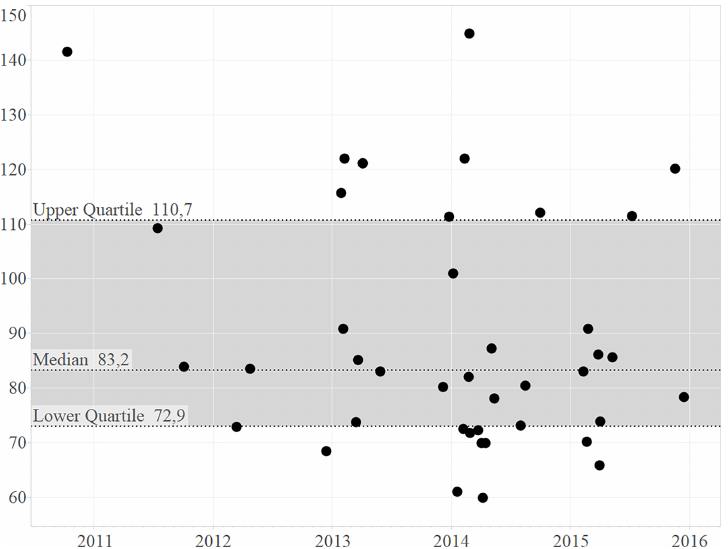
Fig 2. Age at first calving by calving date. The figure shows the age at first calving(month–Y-axis) over time (years–X-axis). The dots in Fig 2 represent nulliparous females that calved.